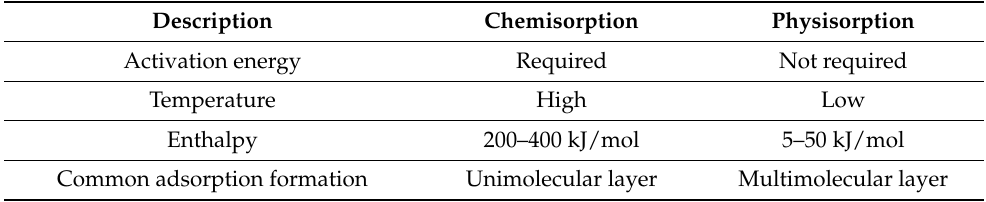
Table 6. Comparison between chemisorption and